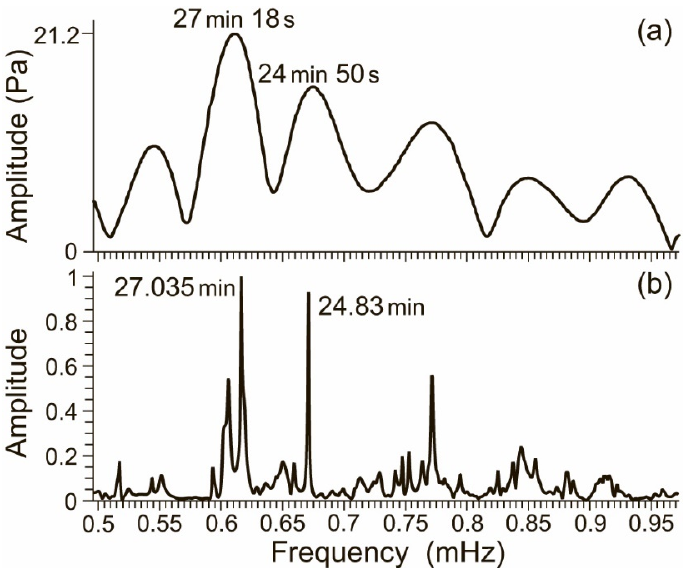
Figure 7. Spectrum of recording fragment of laser meter for hydrosphere pressure variations ( а ) and the resonance curve ( b ). the resonance curve ( b